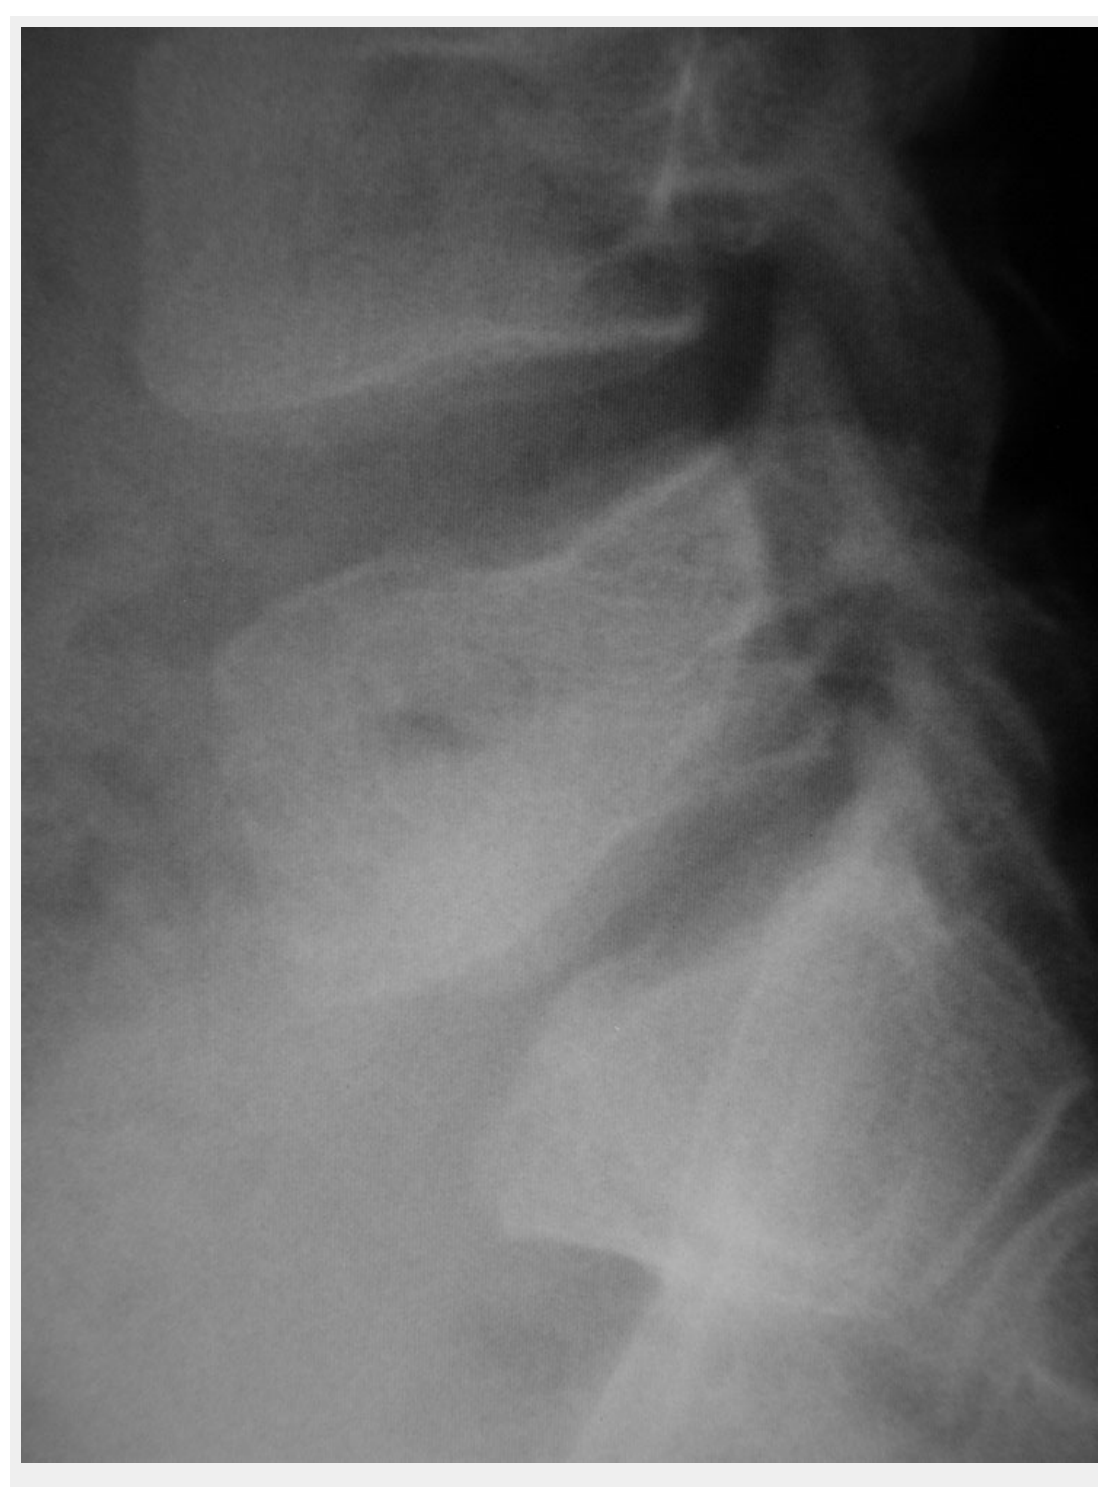
Figure 2 B T2 weighted Magnetic Resonance Image. Lateral sagittal plane. Dehydration of disk L5/S1 with subsequent disk space narrowing and posterior bulging of the disk. Anterior osseous destruction of the first sacral vertebra. Marked anterior Schmorl’s nodes at the lower endplate of L5 and upper endplate of